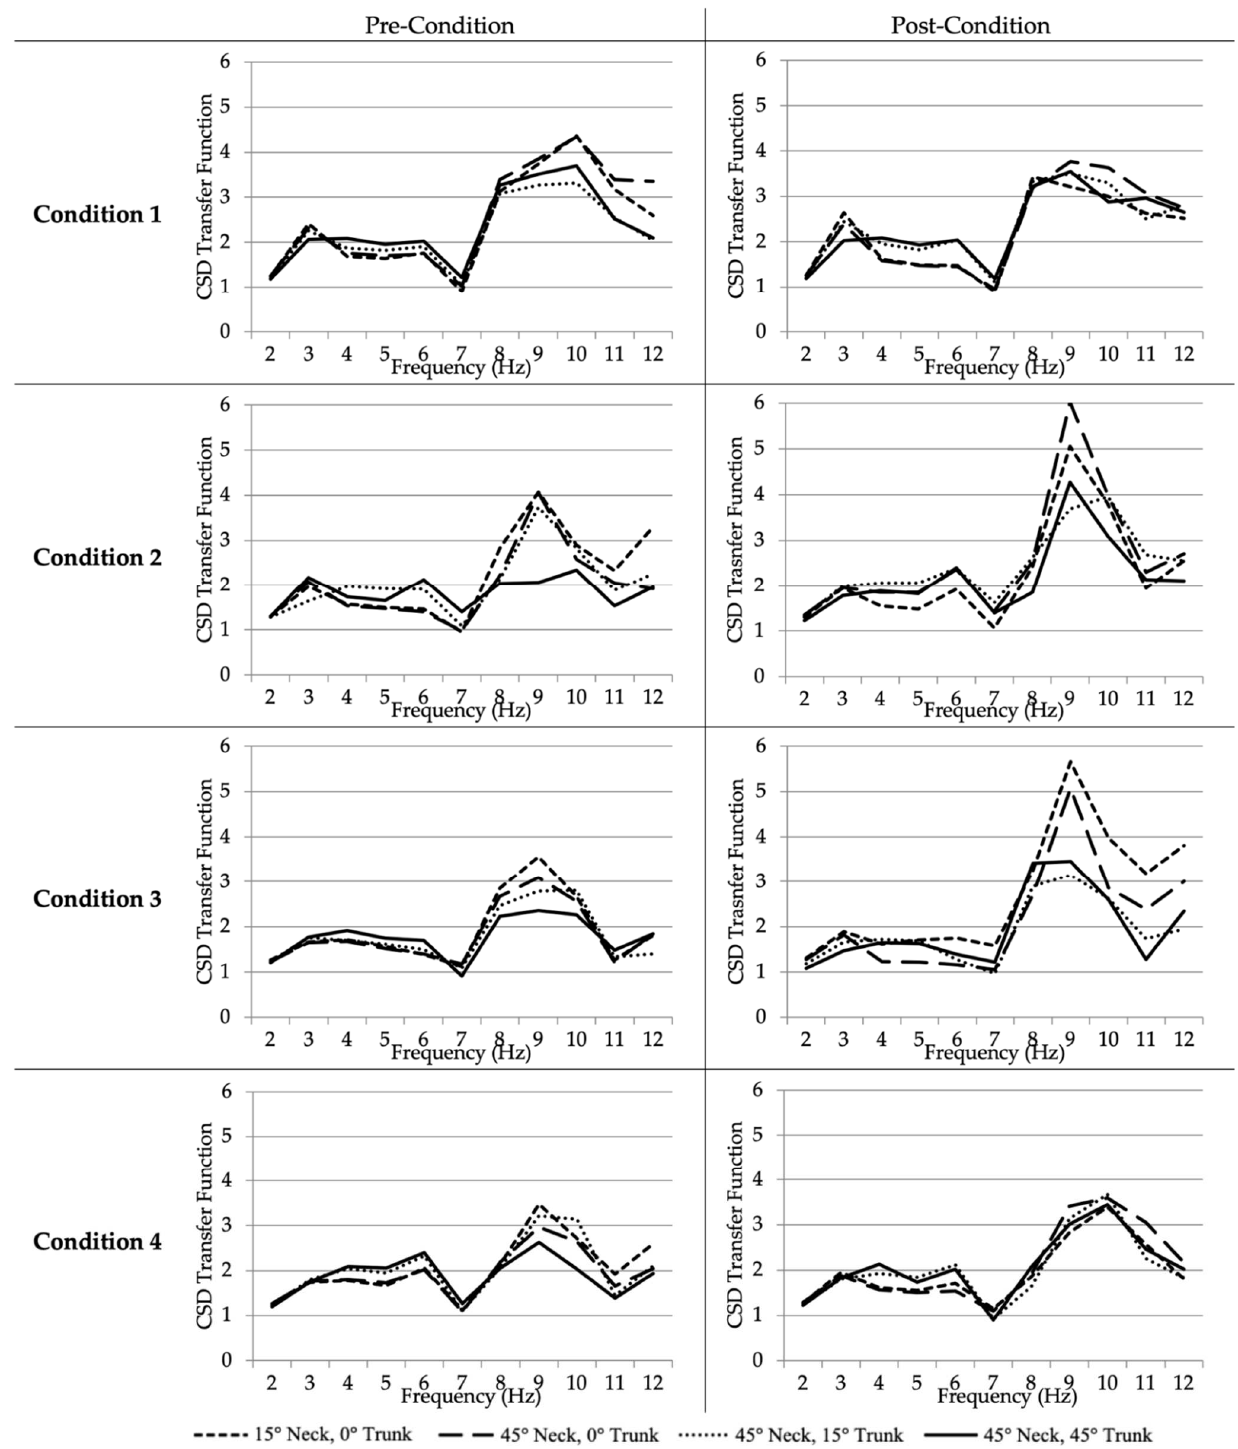
Figure 6. The pre- and post-condition, CSD transfer functions from 2 to 12 Hz for all four rotated trunk and neck postures. Coherence values were not consistently above the 0.5 cut-off point at 6 Hz and should be interpreted with extreme caution.